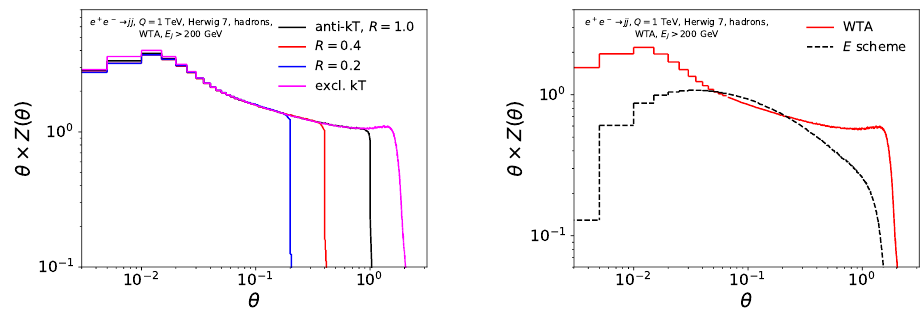
Figure 11 . Left panel: the jet shape as function of the angle for di(cid:11)erent values of the jet radius R , and for exclusive k T . The curves are normalized in (cid:18) = [0 : 1 ; 0 : 2]. Right panel: the jet shape for exclusive k T (two jets) as function of angle with the WTA axis (red) and standard jet axis (black